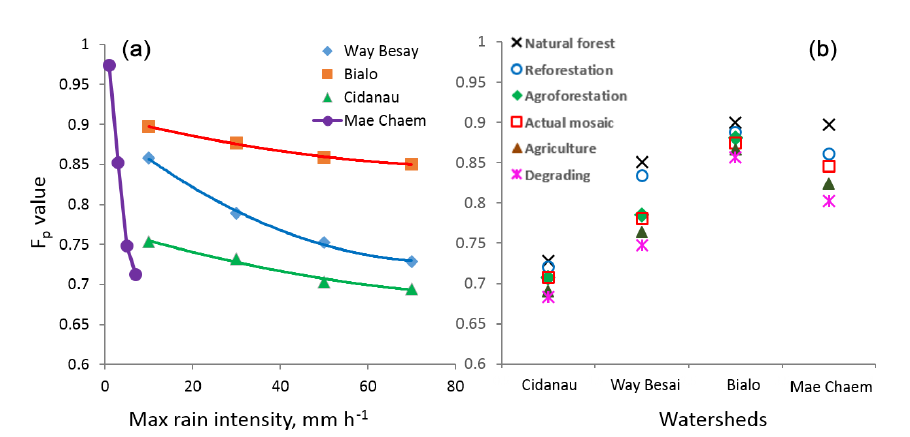
Figure 4. Inter- (a) and intra-annual (b) variation in the F p parameter derived from empirical vs. modelled flow: for the four test sites on annual basis (a) or 3-monthly basis (b)